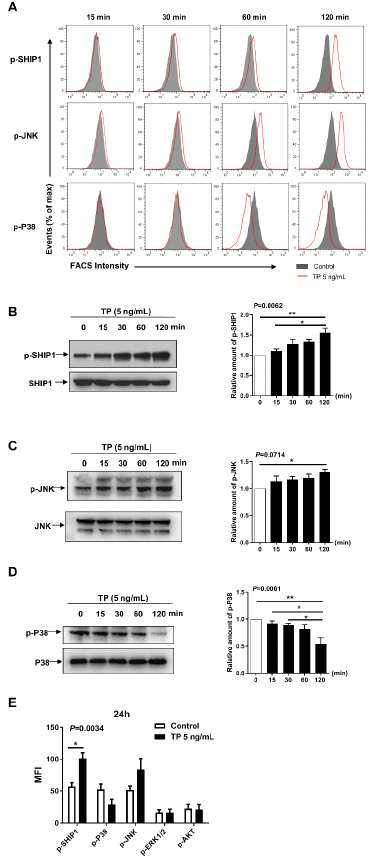
Figure 5. Effects of TP on intracellular signaling in NK cells. ( A ) Human NK cells were stimulated with TP (5 ng/mL) for 0/15/30/60/120 min, and then the expression of p-SHIP1, P-P38, and p-JNK were measured by flow cytometry. ( B – D ) Human NK cells were treated with TP (5 ng/mL) for indicated time periods. Cells were lysed and protein was extracted, the expression of p-SHIP1, p-P38 and p-JNK were tested by western blot. ( E ) Human NK cells were treated with TP (5 ng/mL) for 24 h, flow cytometric analysis of p-SHIP1, p-JNK, p-ERK1/2, p-P38 and p-Akt were carried out on NK cells. Data were analyzed by one-way analysis (( B – D ), n = 3) and two-way analysis of variance with a multiple comparisons test (( E ), n = 5), * p < 0.05, ** p < 0.01.